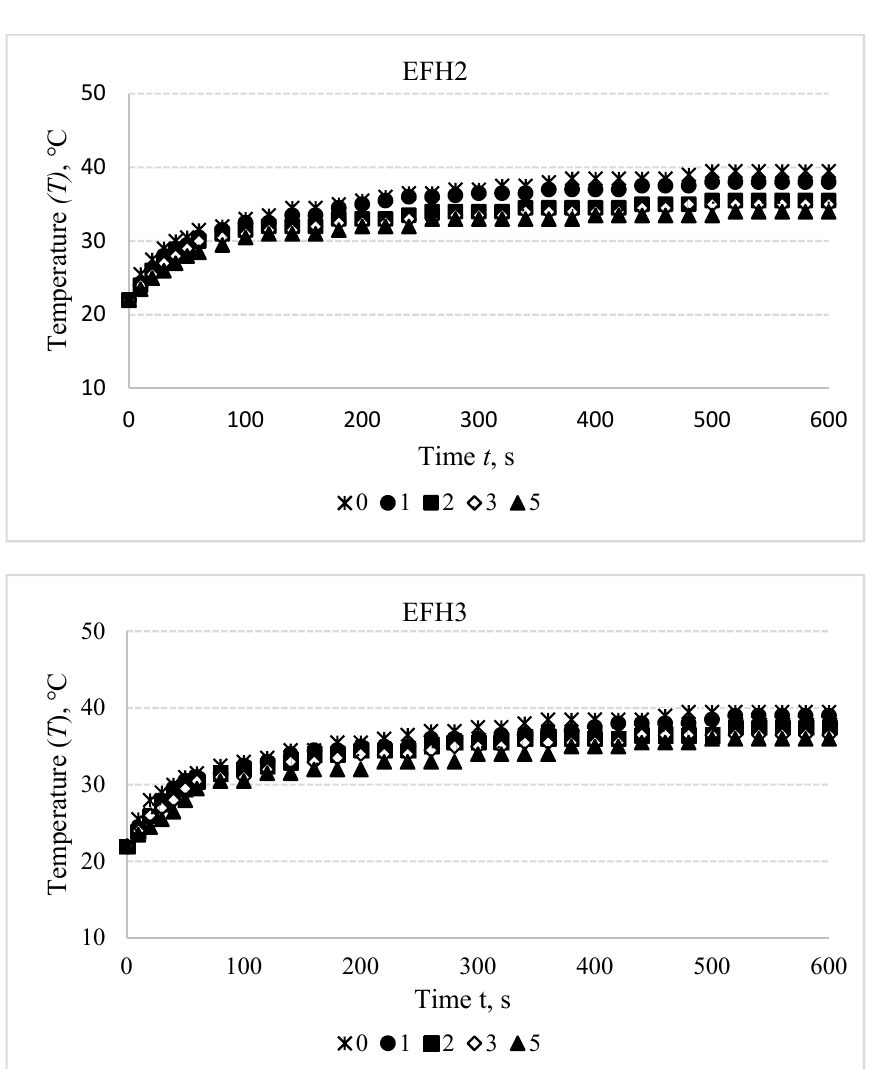
Figure 12. Temperature changes of EFL1, EFL2, EFL3, EFH1, EFH2, and EFH3 structured electro- conductive fabric during the 600 s period before and after different washing cycles (1, 2, 3, 5) at 30% stretch.